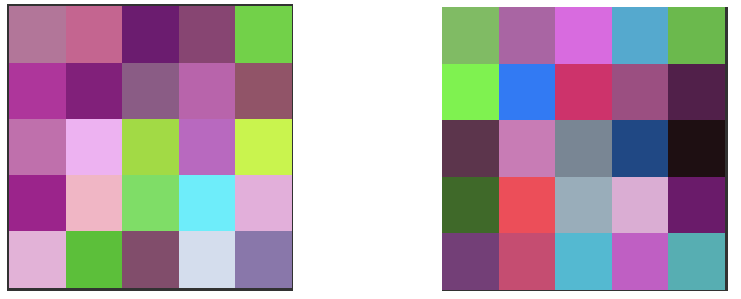
Figure 3. Corresponding image reconstructions of the time series in Figure